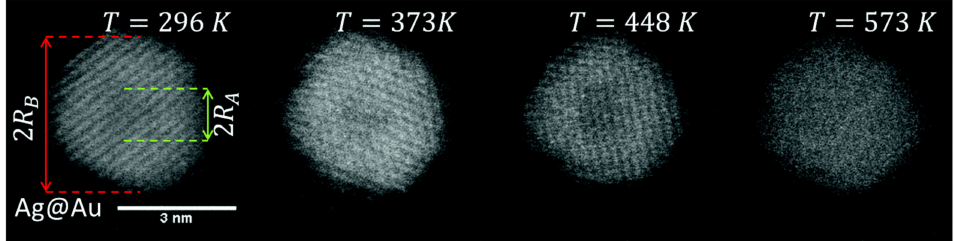
Figure 16. HAADF images of a single Ag@Au nanoparticle produced by the He droplet method (Figure 2f) during heating. The as-deposited nanoparticle showed a core–shell structure because the HAADF intensity was proportional to z 2 . At 573 K, the core–shell structure disappeared, and the nanoparticle formed the alloy, which is the expected equilibrium structure. Reproduced with permission from [136].